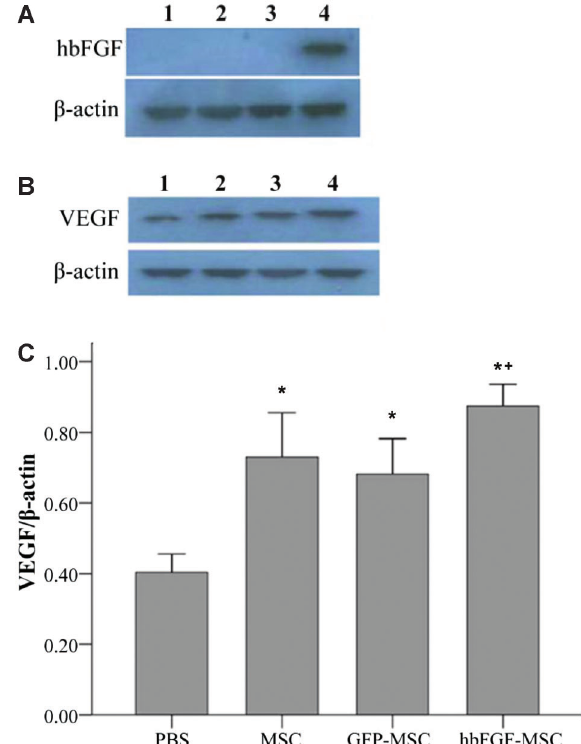
Figure 2. Overexpression of human basic fibroblast growth factor (hbFGF) by mesenchymal stem cells (MSCs) in a rat hind limb ischemia model. A , hbFGF and B , vascular endothelial growth factor (VEGF) protein expression was determined by Western blot analysis. 1 , PBS group (n=6); 2 , MSC group (n=6); 3 , green fluorescent protein (GFP)-MSC group (n=6); 4 , hbFGF-MSC group (n=6). C , Relative VEGF expression was determined after normalization to b -actin. *P , 0.05, compared to PBS group; + P , 0.05, compared to GFP-MSC group (n=6 for each group) (ANOVA with Bonferroni post hoc